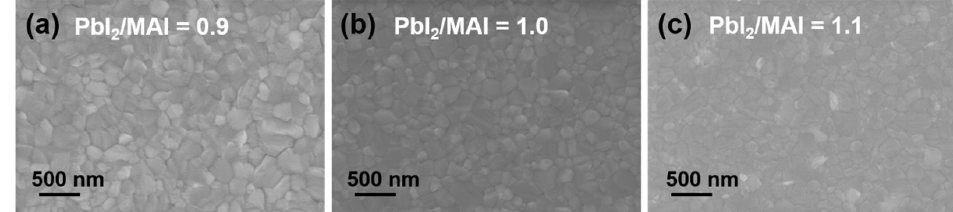
Figure 5. Scanning electron microscope (SEM) images. Surface SEM of MAPbI 3 films on Glass/ITO/PEDOT:PSS with different PbI 2 /MAI ratio of ( a ) 0.9, ( b ) 1.0, ( c ) 1.1. The scale bars are 500 nm for all images.